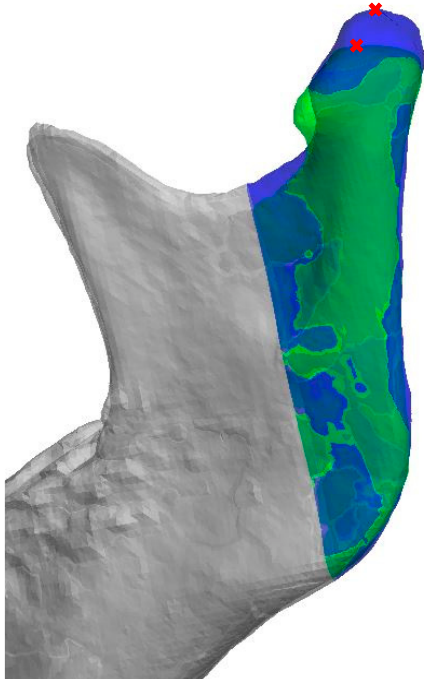
Figure 3. Three-dimensional representation of both the original (blue) as well as the aligned mirrored (green) side of the mandibular bone. The tangent of the mandibular ramus of both sides is positioned vertically, and the highest point on each condyle is marked in red. The difference in condylar height is equal to the vertical height difference of both points.